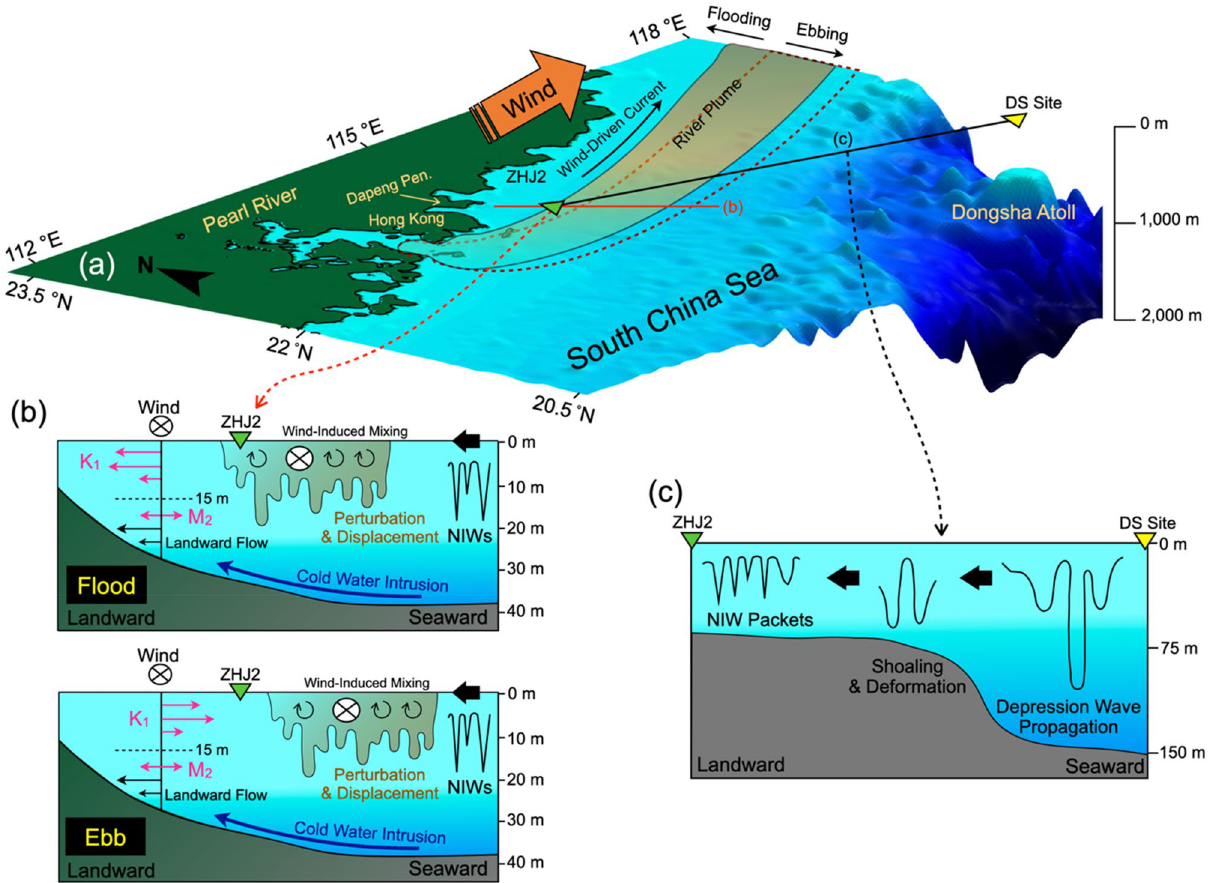
Figure 7. The schematic diagram describing the coupling mechanisms. ( a ) shows the coupling mechanisms among the wind, river plume dispersal, and tidal motions, and ( b ) the cross-section shows the mechanisms including wind and tidal mixings, NIW-induced perturbation, and cold water intrusion. The upper and lower panels show the period during flood and ebb, respectively. ( c ) The landward propagation of NIWs from the South China Sea between DS and ZHJ2 showing transformation from elevation waves to depression waves. The bold arrows indicate the direction of the NIW propagation along the orientation of the 2-D